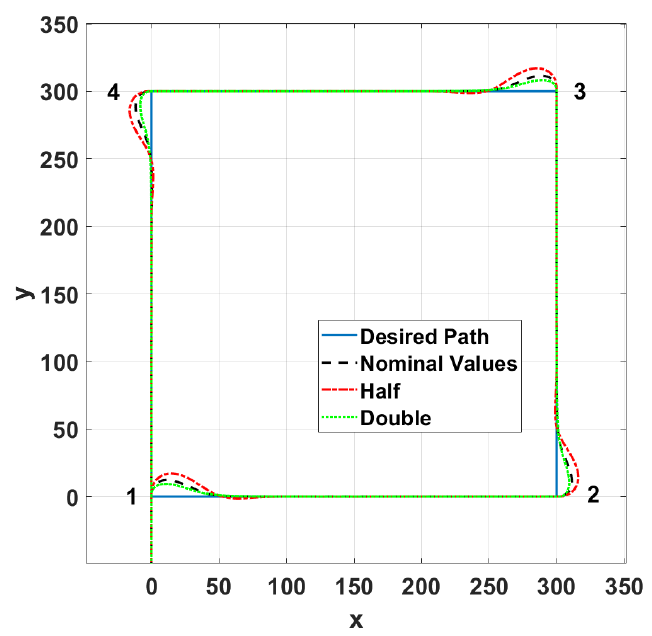
Figure 17. Effect of changing the aerodynamics coefficients.